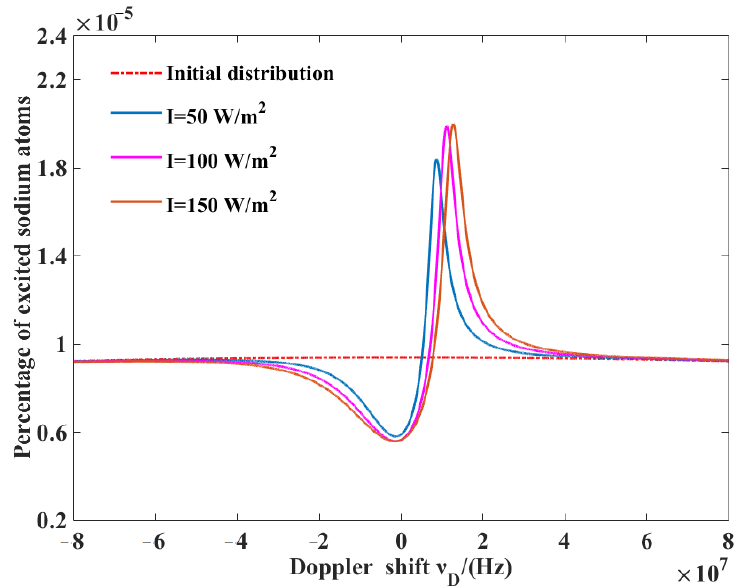
Figure 4. Normalized distributions of sodium atoms with recoil for I = 50 W/m 2 , 100 W/m 2 , and 150 W/m 2 for 0 MHz